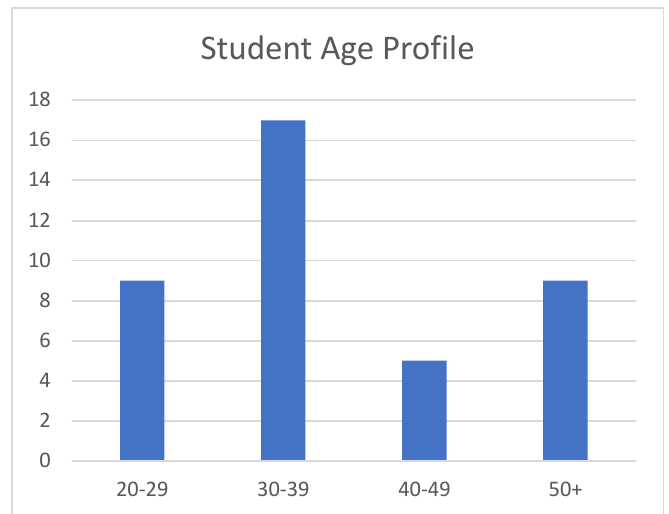
Figure 4. Student age